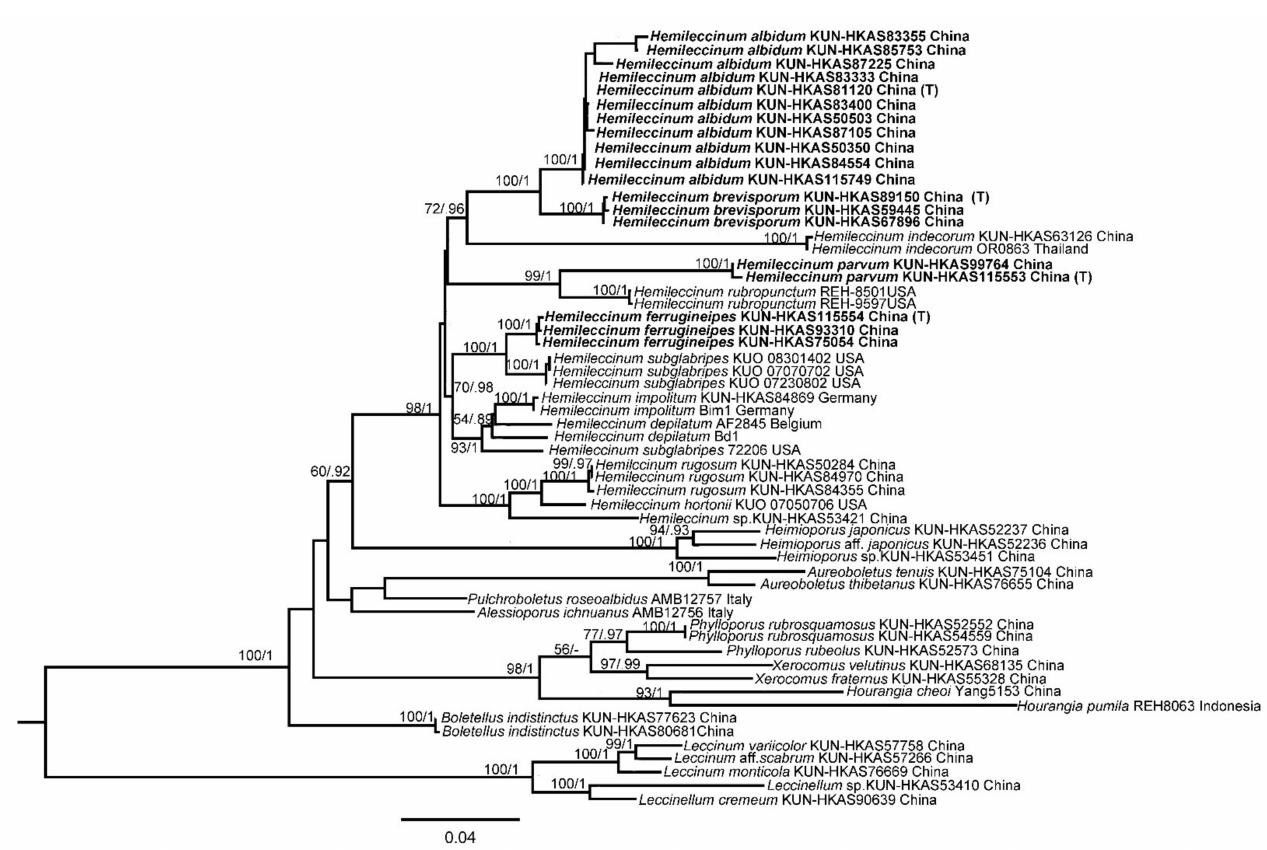
Figure 3. Maximum-Likelihood analysis of Hemileccinum with nrLSU, tef1- α , rpb1 and rpb2 sequence data. Bootstrap values (BP) ≥ 50% from ML analysis and Bayesian posterior probabilities (PP) ≥ 0.90 are shown on the branches. Newly described species are indicated in bold and their type specimens are marked with